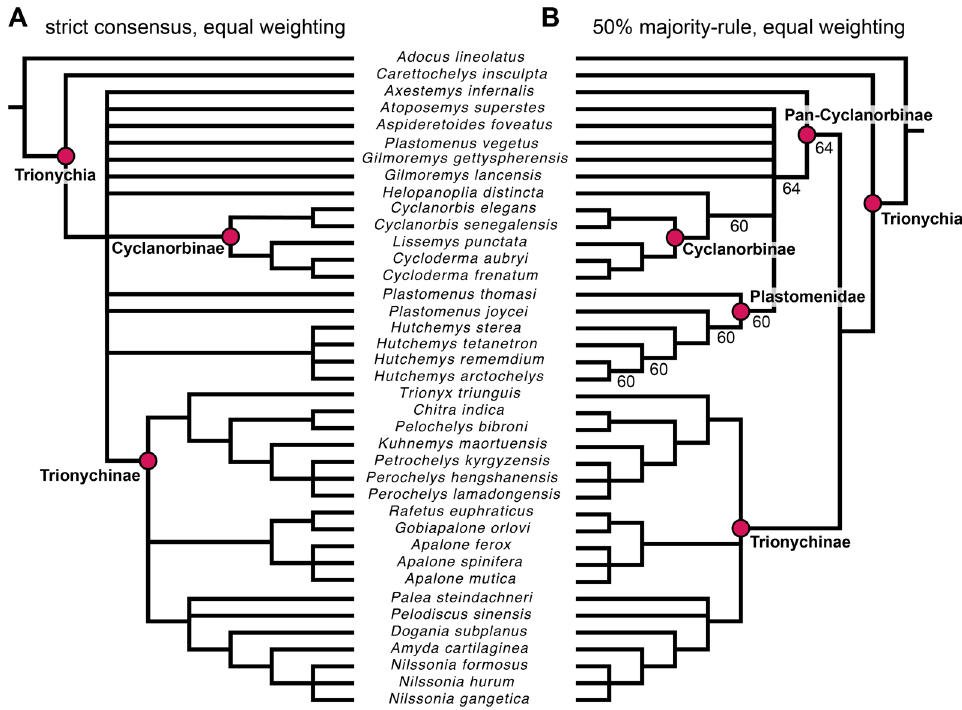
Fig. 12 Phylogenetic results of parsimony analysis using equal weights. A strict consensus tree of 75 MPTs. B 50% majority rule tree constructed from MPTs, with numbers indicating the proportion of MPTs in which a specific node is found. Nodes without numbers in B are found in all MPTs, whereas polytomies represent nodes in which no possible resolution receives more than 50% support. Main clades are